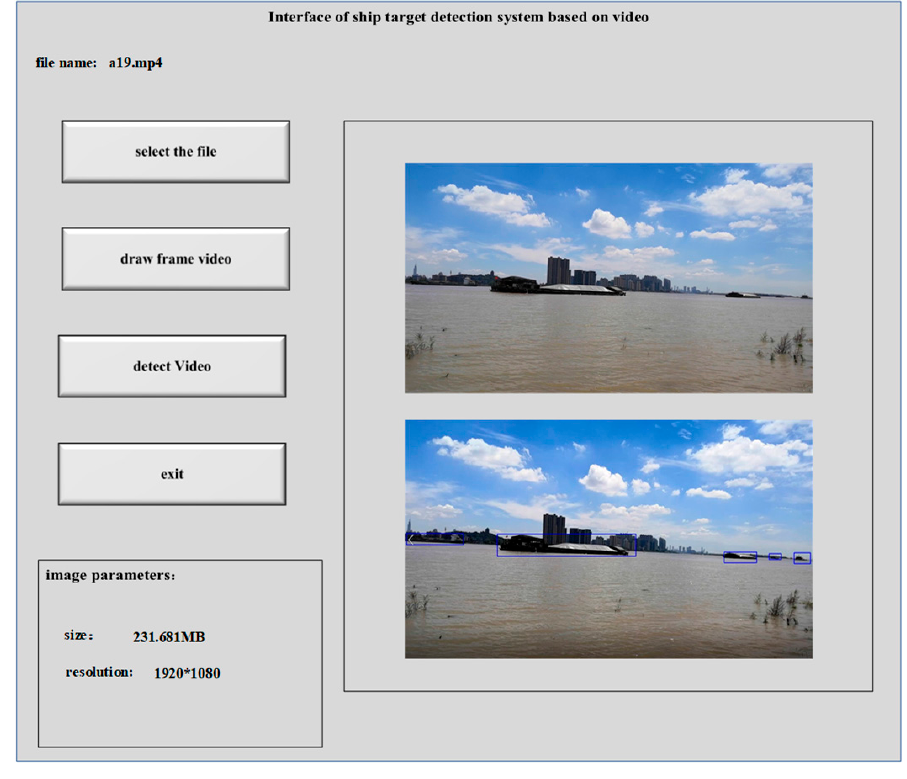
Figure 12. Training loss function line chart.